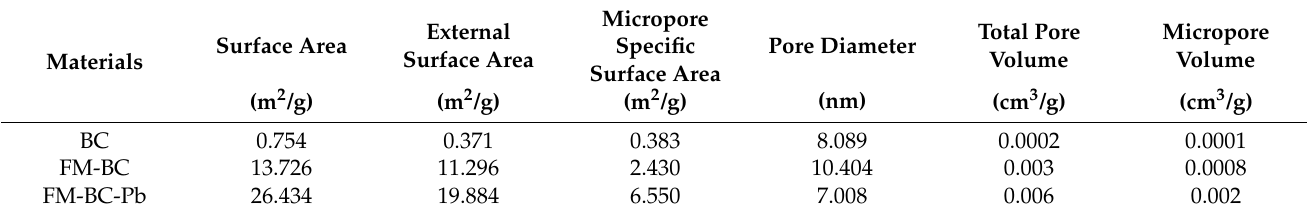
Table 1. Surface property parameters of